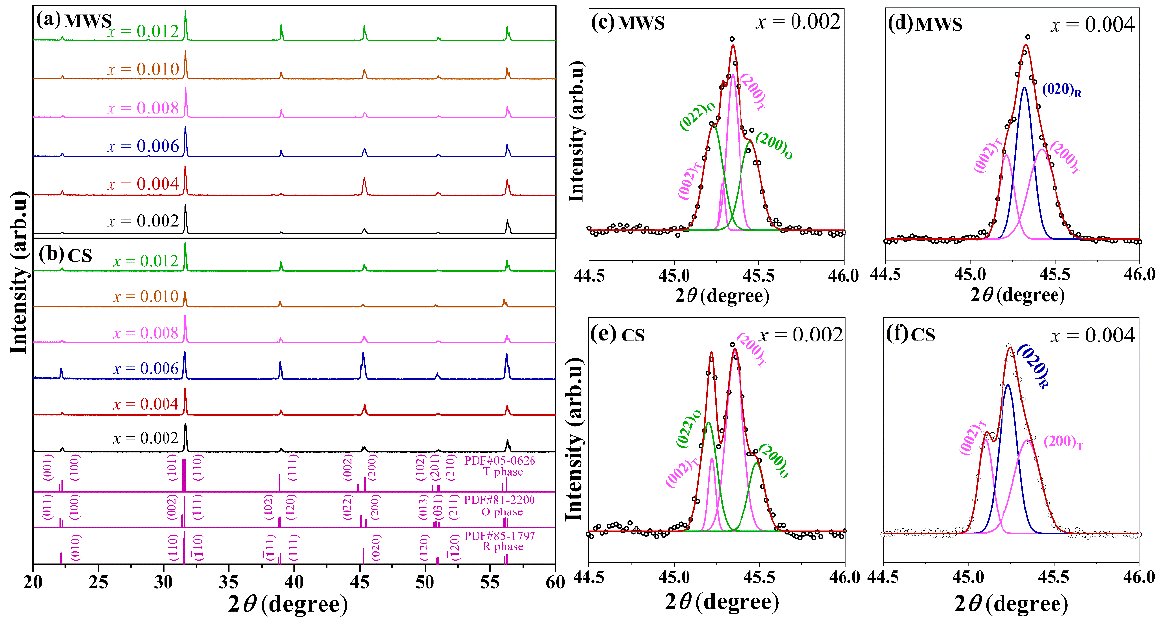
Figure 1. XRD patterns of BTS-BCT- x BF ceramics sintered with ( a ) MWS and ( b ) CS; enlarged XRD patterns with multi peak fitting of BTS-BCT- x BF ceramics with ( c ) x = 0.002, ( d ) x = 0.004 sintered by MWS; enlarged XRD patterns with multi-peak fitting of BTS-BCT- x BF ceramics with ( e ) x = 0.002, ( f ) x = 0.004 sintered by CS.